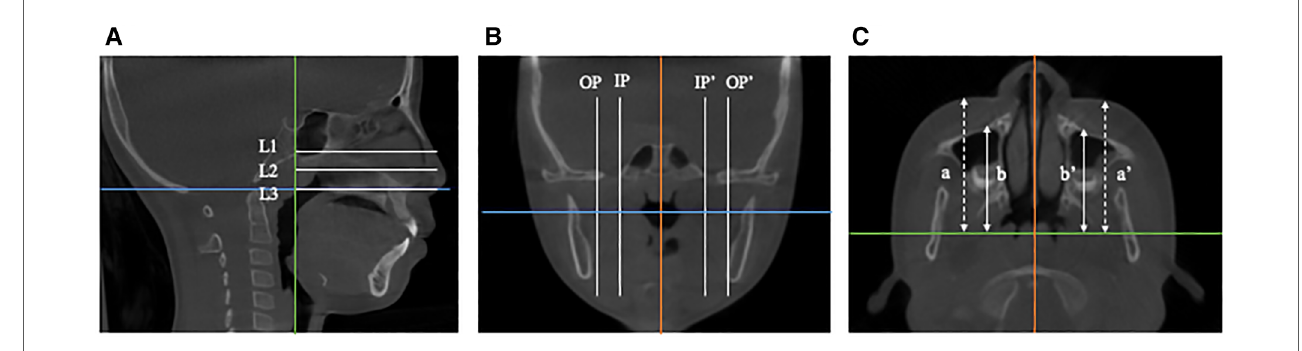
FIGURE 4 Measurements of the mid-facial depth. (A) Sagittal plane.The horizontal planes are paralleled to the FH plane, including the FH plane (L1), the plane through the anterior nasal spine (L3), and the plane (L2) bisecting L1 and L3. (B) Coronal plane. The bilateral inner (IP) and outer (OP) sagittal planes extend through the orbitale and the outermost rim of the sella, respectively. (C) Horizontal plane. The dotted line (a and a ’ ) represents soft tissue facial depth, and the solid line (b and b ’ ) denotes hard tissue facial